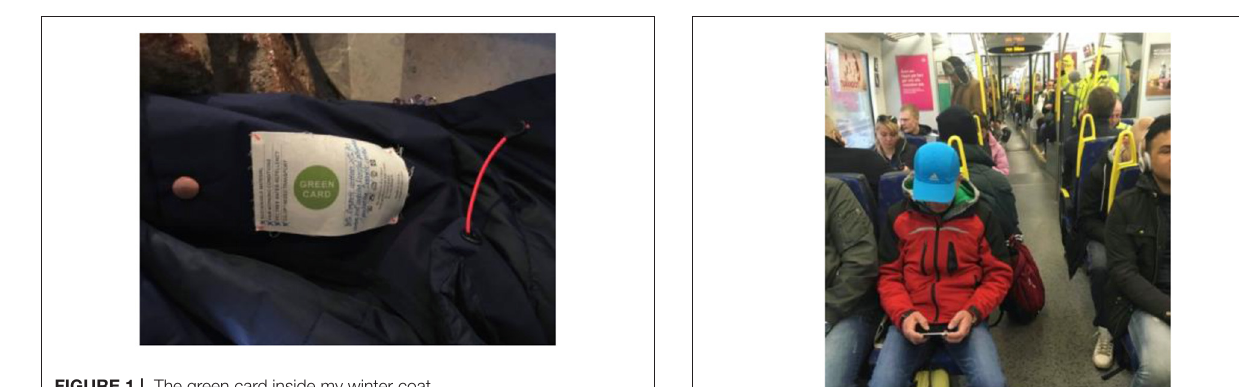
FIGURE 1 | The green card inside my winter coat.